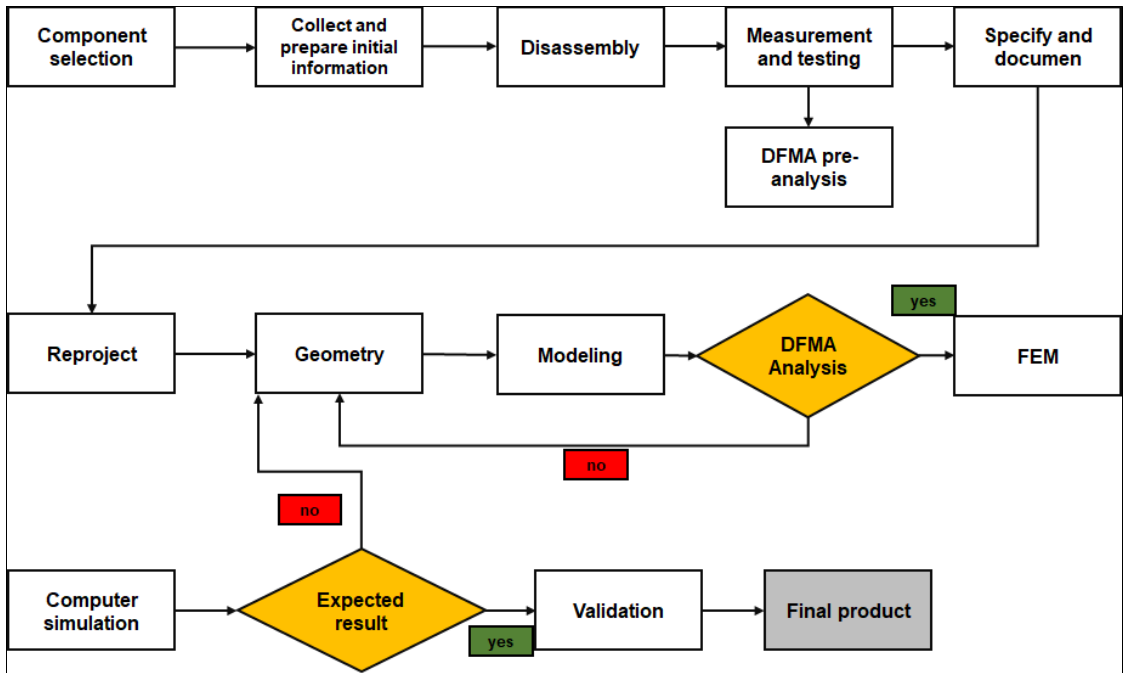
Figure 1: Study methodology applied to landing gear